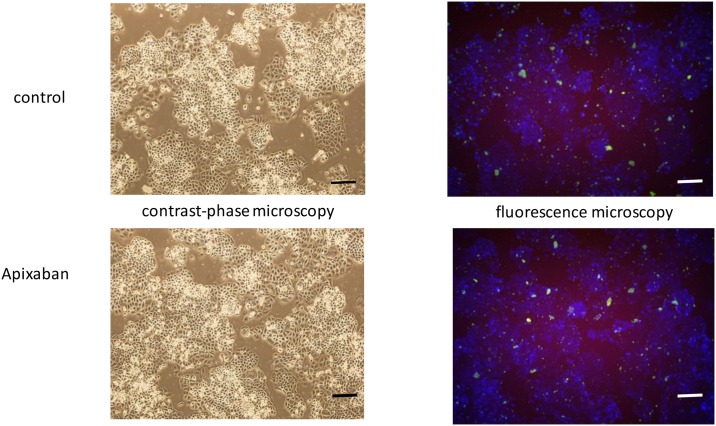
Fig 5 shows an example (control and Apixaban, after 96-h incubation with 5 μg/ml) of apoptosis/necrosis analysis in contrast-phase microscopy fluorescence microscopy for Apixaban and control fluorescence microscopy.The figure shows apoptotic (green, Apopxin green indicator) and necrotic cells (red, indicated by 7-AAD staining). The fluorescence images of the cells were taken with a fluorescence microscope through the FITC (green) and TRITC (red) channels. Individual images taken from each channel from the same cell population were merged in panels B and D. Bars correspond to 100μm; magnification 10x.